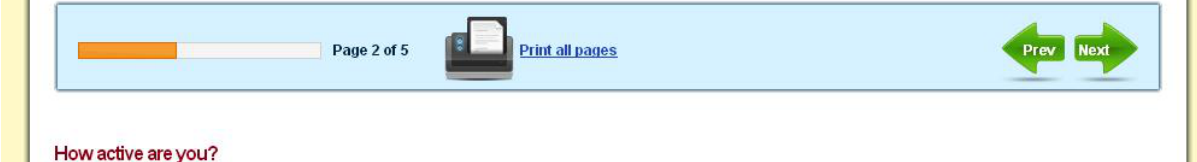
Figure 4. Screenshot of text mode